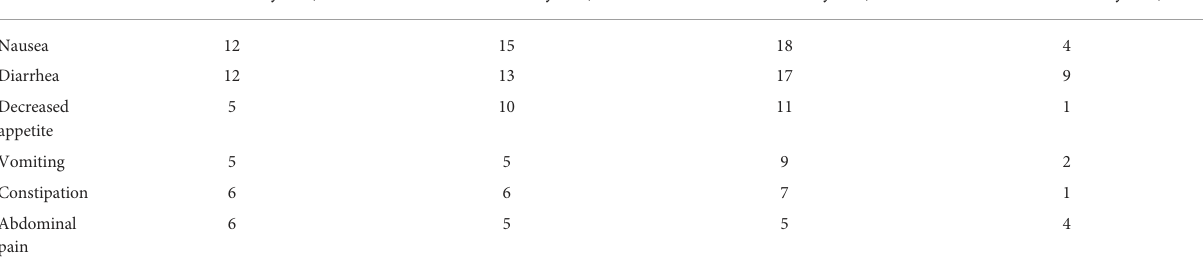
TABLE 3 Pooled gastrointestinal adverse events associated with tirzepatide treatment in the SURPASS 1 and SURPASS 5 studies compared to comparator treatment in type 2 diabetes (54, 70, 75). Symptom Tirzepatide 5 mg (total n = 237; % of